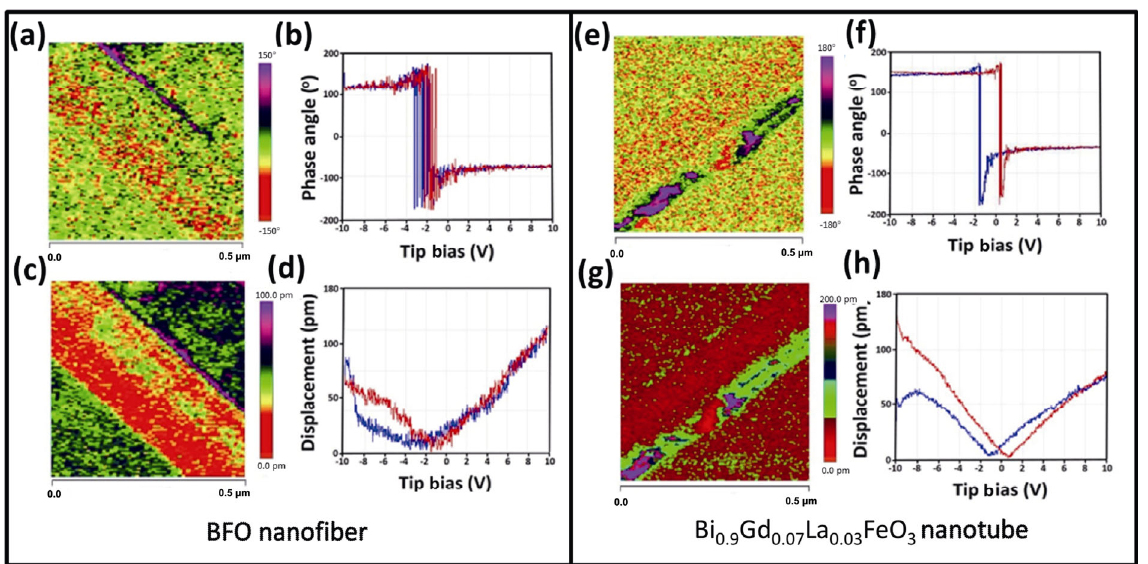
Fig. 5 PFM characterization of BFO and Bi 0.9 Gd 0.07 La 0.03 FeO 3 nanotubes: (a, e) phase contrast maps; (b, f) phase–voltage hysteresis loops; (c, g) amplitude maps; and (d, h) amplitude–voltage butterfly